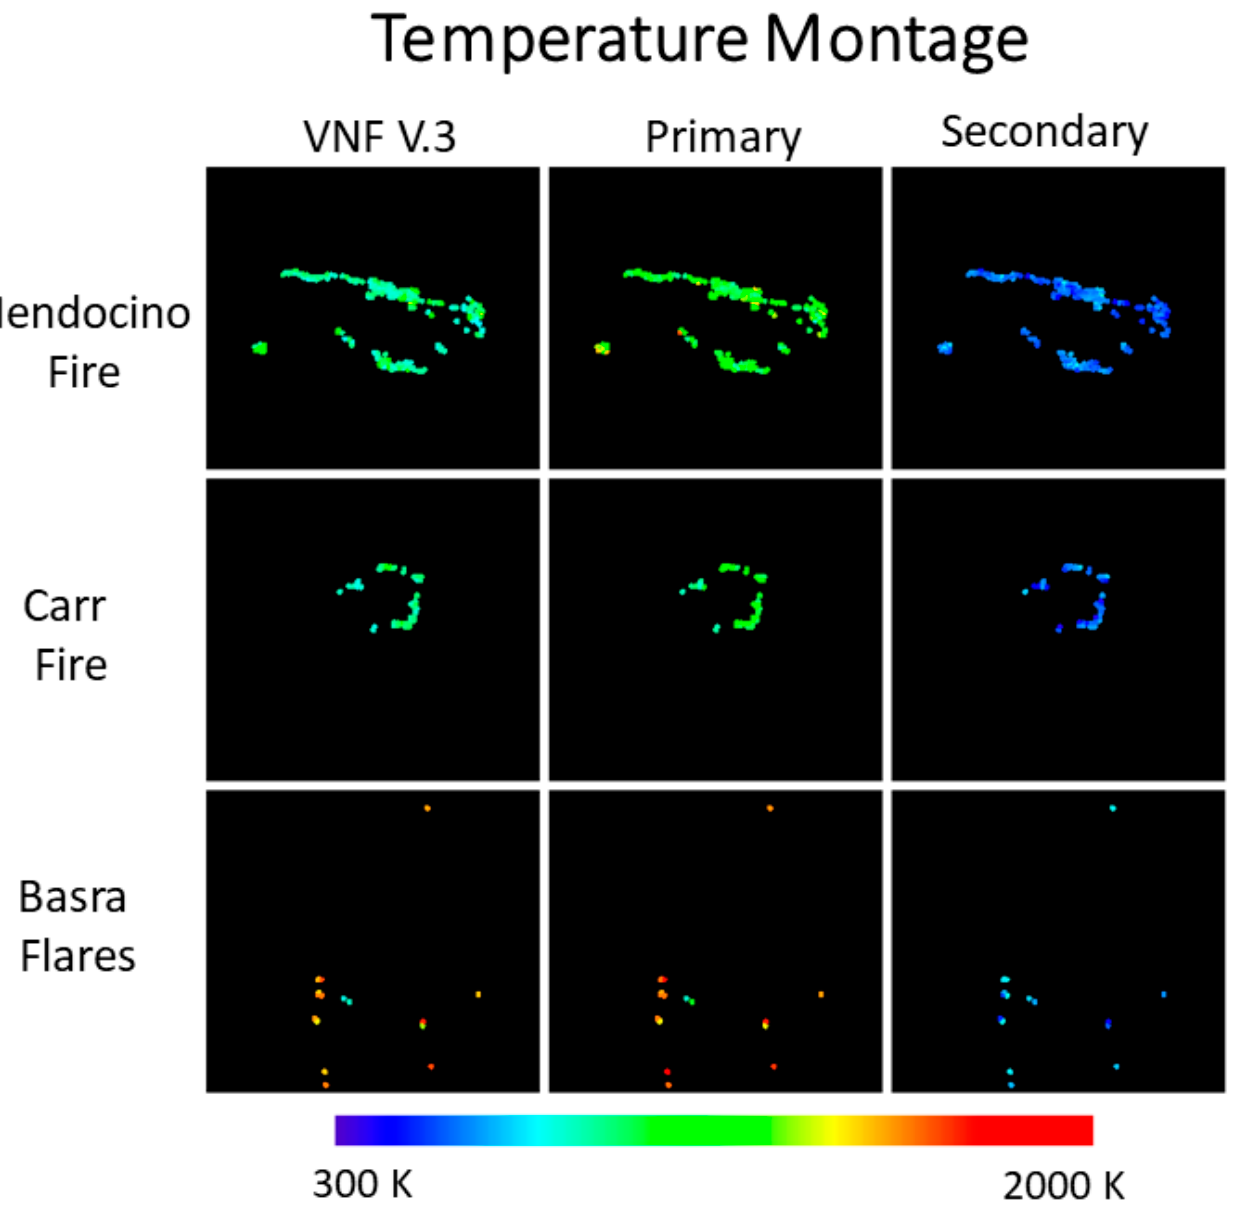
Figure 18. Temperature images for the Type 4 detections found to have primary and secondary emitters from the flaming subtractive processing. The VNF v.3 temperatures are in the left-hand column. The primary emitter temperatures from the flaming subtractive processing are in the middle column and the secondary emitter temperatures are in the right-hand column.